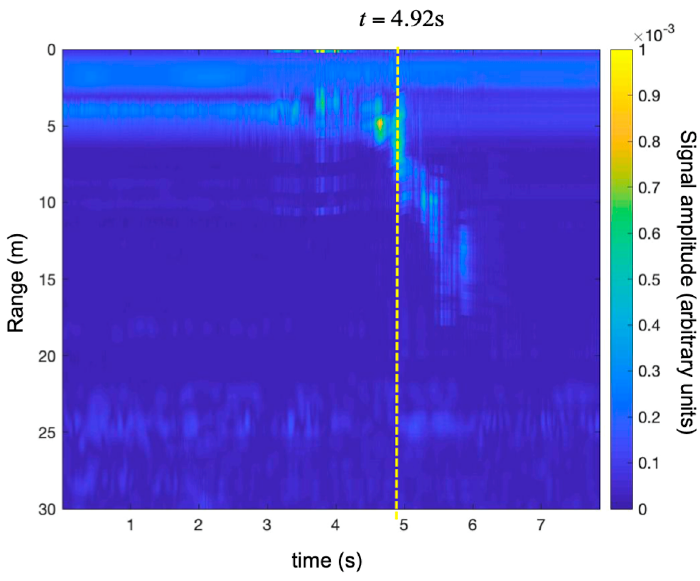
Figure 19. Detection of a small UAV using an SFCW radar. Time-range map with the Doppler correction during maneuver 1 (i.e., take-off and rapid running away).